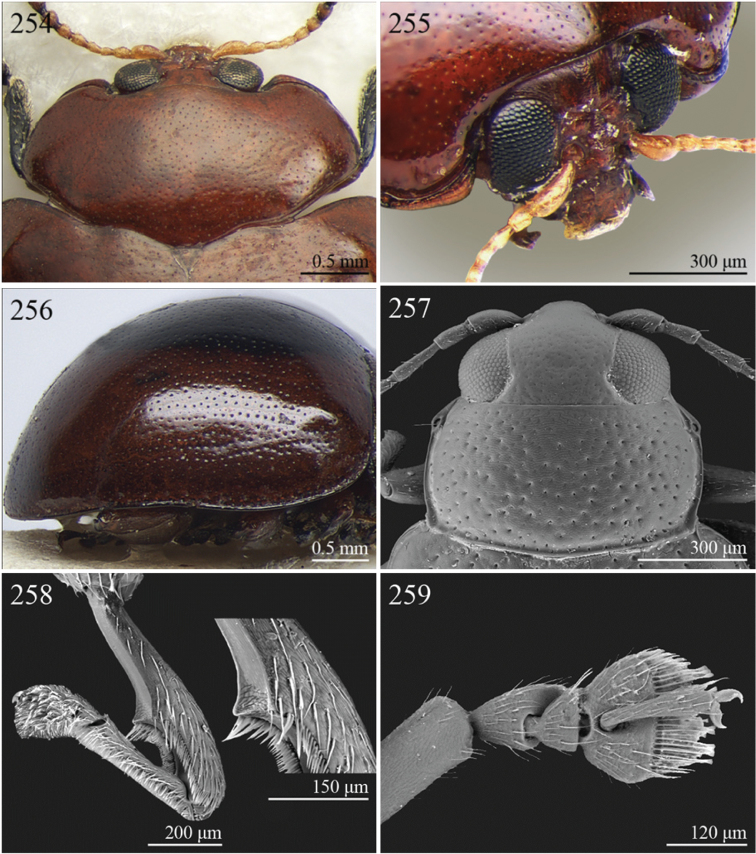
Morphological characters. 254
Sesquiphaera mashonana (Jacoby), head and pronotum in dorsal view 255 Ditto, head and anterior margin of pronotum in subfrontal view 256
Sesquiphaera nigrosignata (Bryant), elytra in lateral view 257
Seychellaltica krishna (Maulik), head and pronotum in dorsal view 258 Ditto, hind tibia and metatarsus 259 Ditto, protarsus in dorsal view.